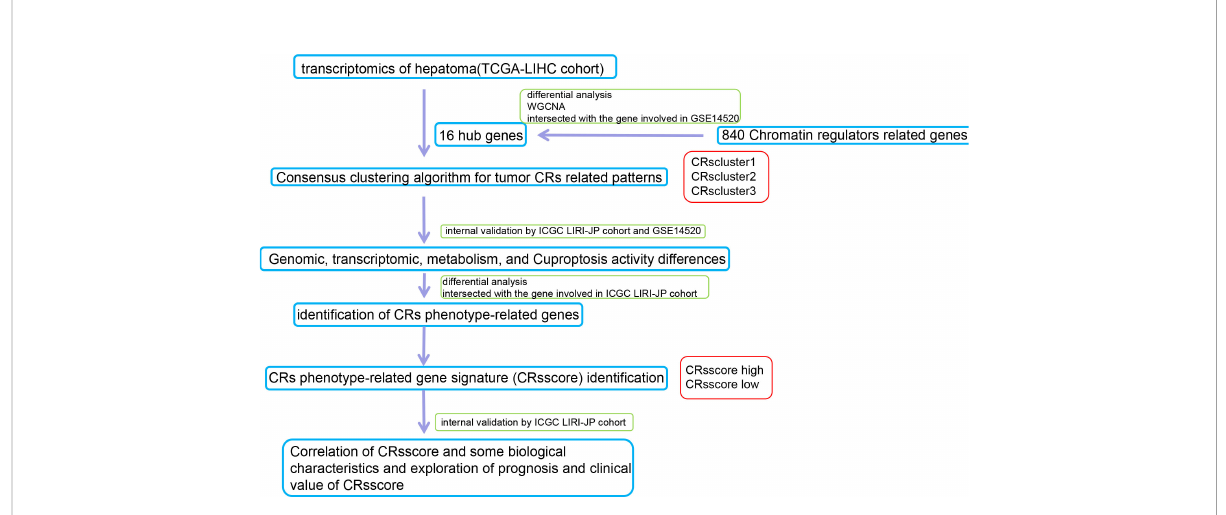
FIGURE 1 Schematic summary of the work fl